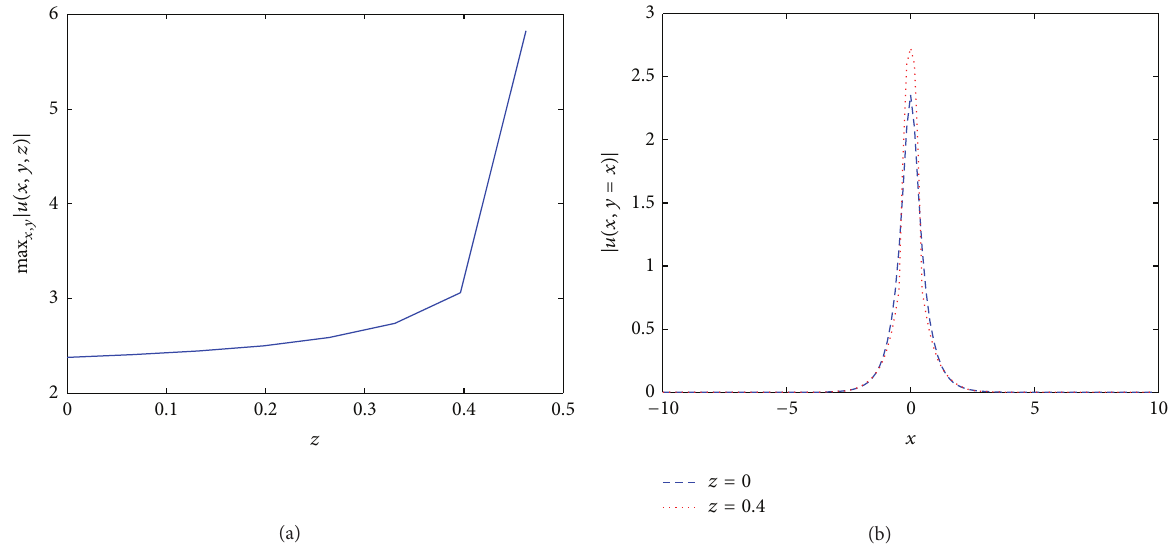
Figure 19: Nonlinear evolution of the lattice soliton without the optical lattice with 𝜇 = 1.5 for the self-focusing cubic and the self-focusing quintic model. (a) Peak amplitude of the lattice soliton as a function of the propagation distance. The initial condition is taken as the lattice soliton with a 0.01 noise in the amplitude and phase; (b) cross section along the diagonal axis of the lattice soliton before and after evolutions ( 𝑧 = 0 and 𝑧 = 0.4 ).